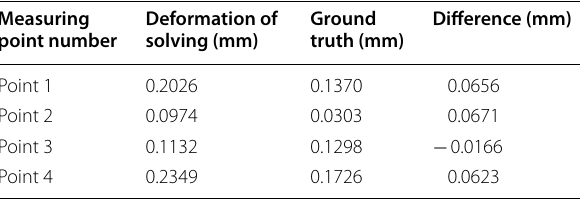
Table 4 The solved deformation values and error compared with ground truth for milling depth of 23 mm Measuring point